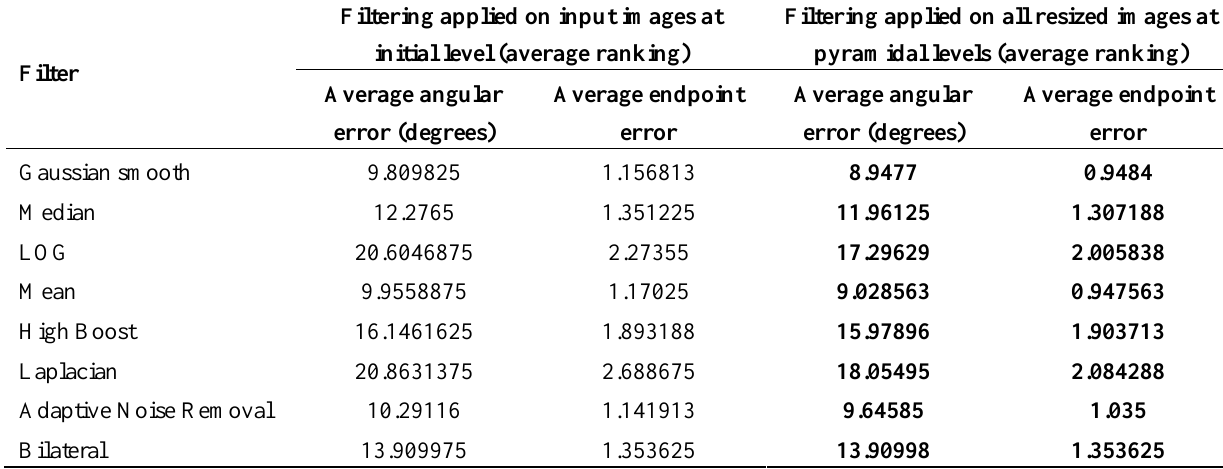
Table 3. Comparison between filtering methods at initial level and all pyramidal levels using average